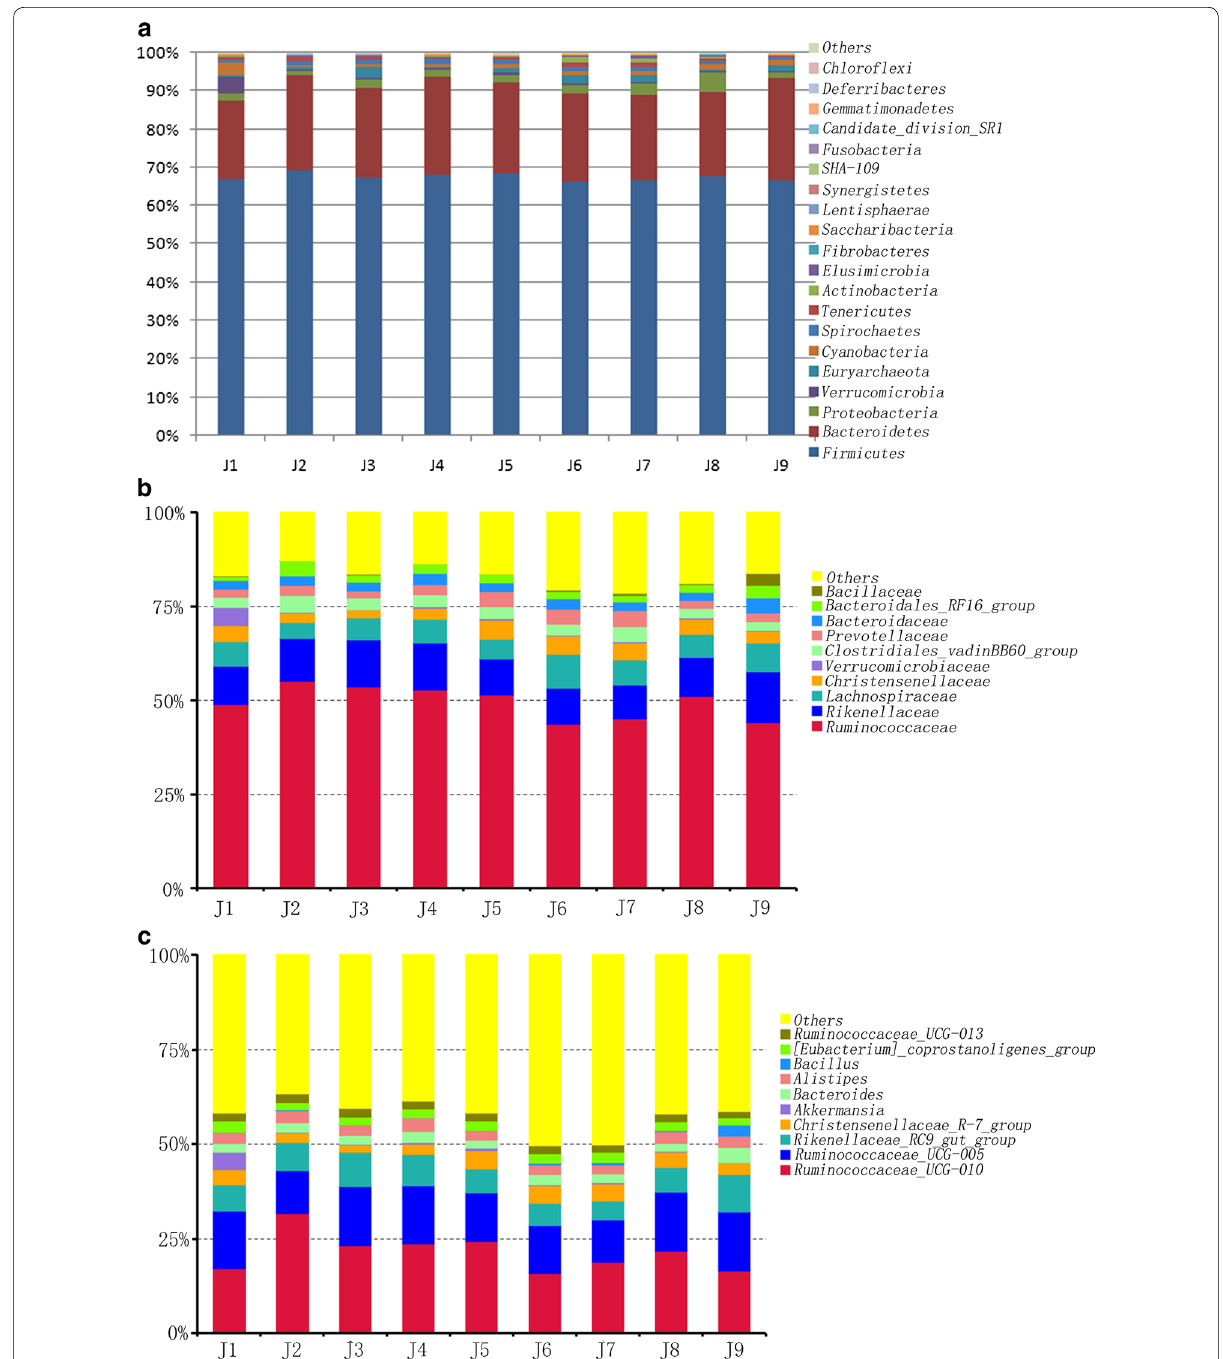
Fig. 3 Gut bacterial composition at the phylum level per sample ( a ) and the relative abundance of the top ten biological species at the family level ( b ) and the genus level ( c